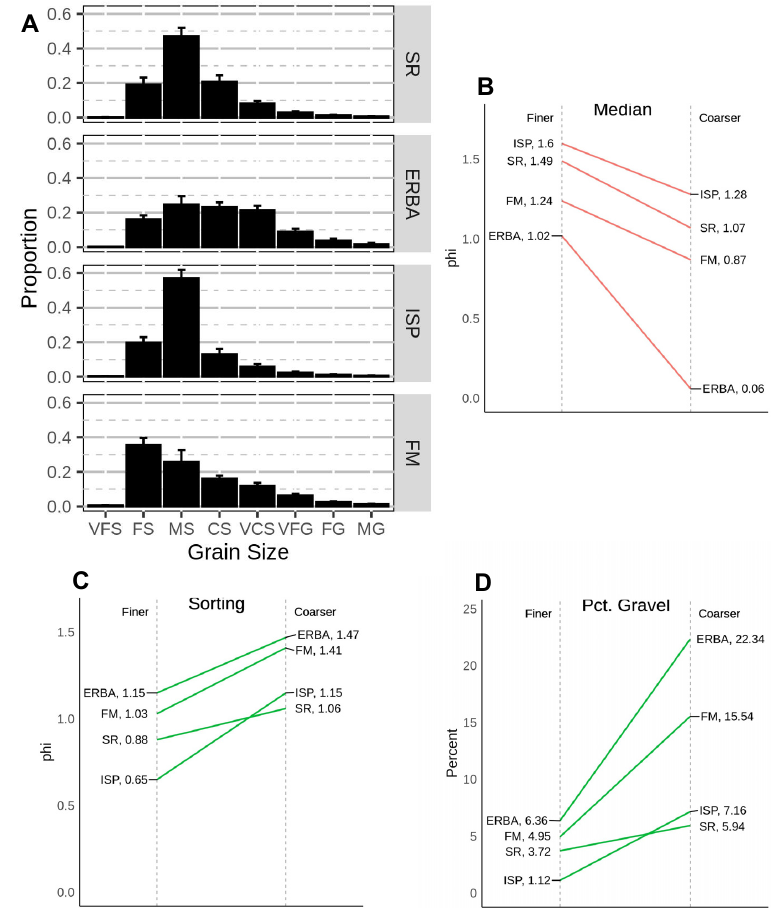
Figure 5. Relative grain size distributions of sediments collected in the low intertidal of several Bogue Banks beaches in June of 2006: ( A ) beach codes same as in Figure 1, grain size category codes same as in Figure 2. Panels ( B – D ) illustrate some sediment parameters for the "finer" and "coarser" samples collected from each beach. Green lines indicate that the respective value is lower in "finer" sediment samples, red lines indicate higher values in the "finer" sediment samples.